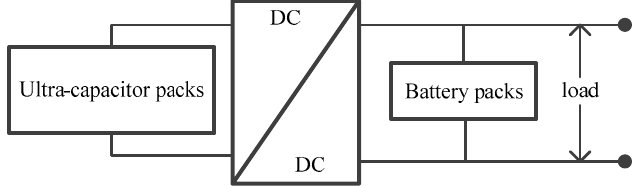
Figure 1. Semi ‐ active structure with direct current (DC)/DC and ultra ‐ capacitor connection. Figure 1. Semi-active structure with direct current (DC)/DC and ultra-capacitor connection. Table 1. Basic parameters of vehicle. Table 1. Basic parameters of vehicle.